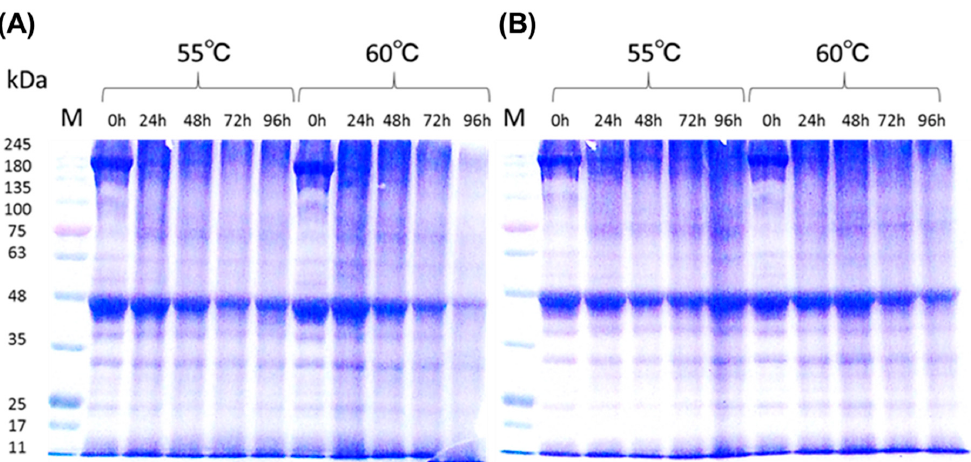
Figure 8. SDS-PAGE analysis of the mixtures of masu salmon reacted at 55 °C ( A ) and 60 °C ( B ) for 96 h. M, protein molecular weight standards.